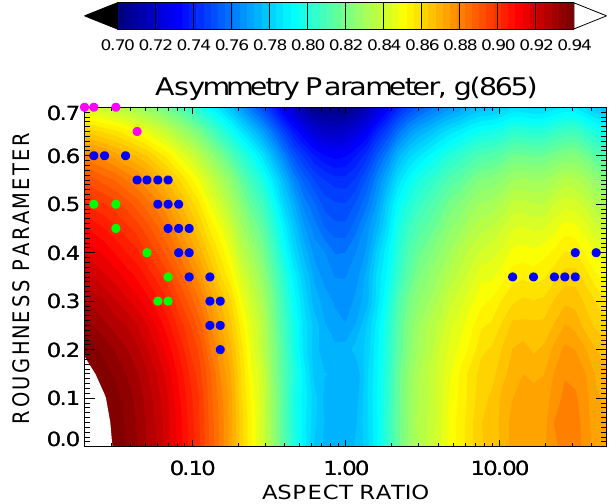
Figure 2. The “butterfly” pattern of the contour plot for the asym- metry parameter g as a function of aspect ratio and roughness pa- rameter resembles that obtained for the RMSE plots in Fig. 1. The red circles in Fig. 1 (here in green for Grand Mesa, magenta for Lake Granby and blue for Derby Peak) that identify the retrieved optimal crystal habits are found for each scene clustered around a single value of g